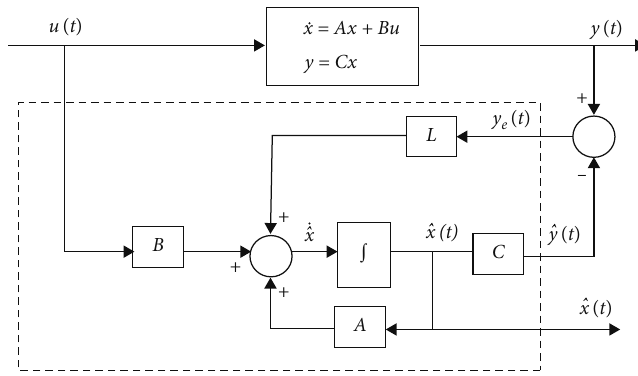
Figure 1: A structure of the Luenberger state observer.